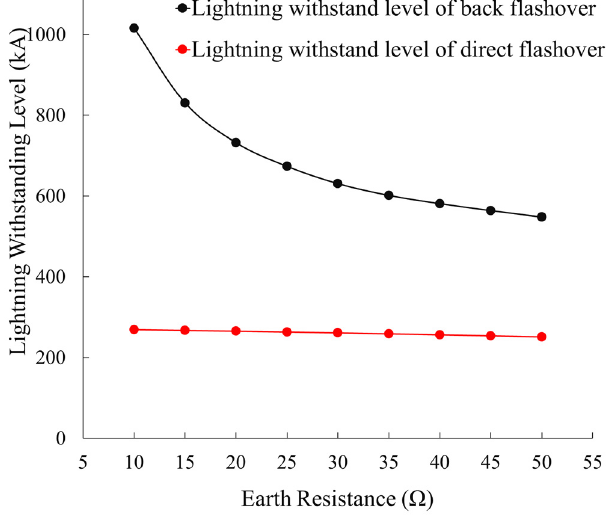
Figure 4. Influence of earth resistance on